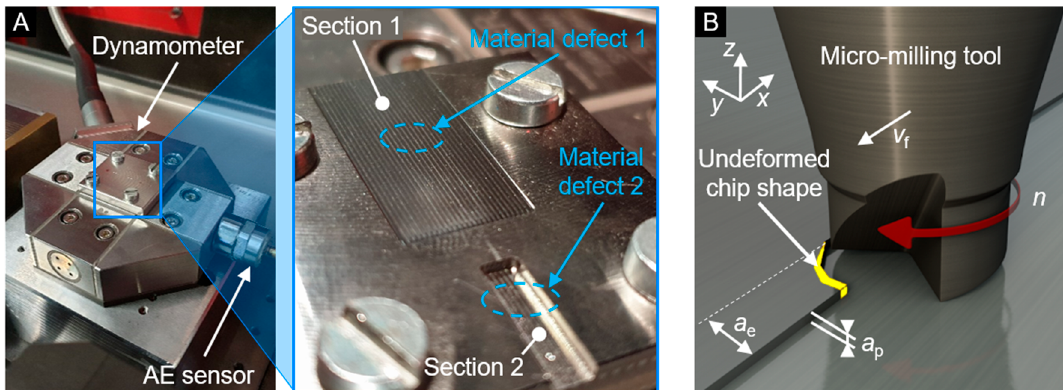
Figure 1. Experimental setup including the measurement systems used and defected workpiece ( A ), and schematic representation of the process configuration ( B ) [19] (Reproduced from D Pfirrmann, J Baumann, E Krebs, D Biermann, K Morik. Real-time prediction of process forces in milling operations using synchronized data fusion of simulation and sensor data. Engineering Applications of Artificial Intelligence. 2021; 99: 165–170 . Copyright © 2021 Elsevier Masson SAS. All rights reserved.